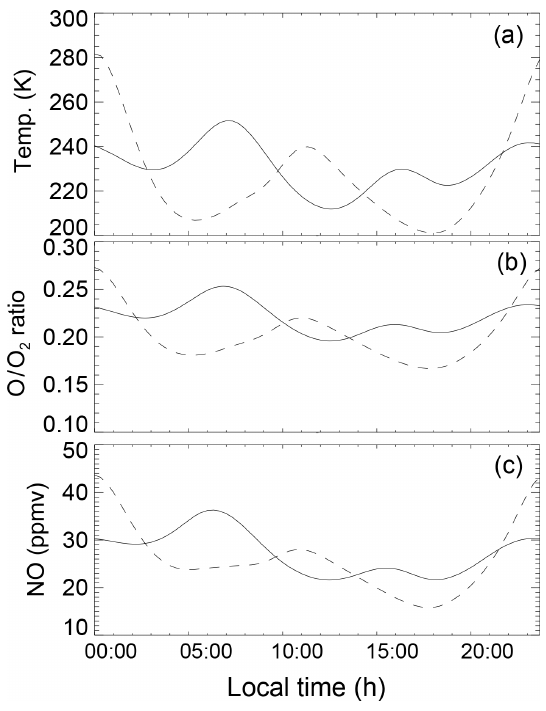
Figure 7. Time variation of ( a ) temperature ( b ) O / O 2 ratio and ( c ) nitric oxide mixing ratio at p = 1 . 1 × 10 − 4 hpa (about 108km). The solid lines are for the nudged model, and the dashed lines are with the driven